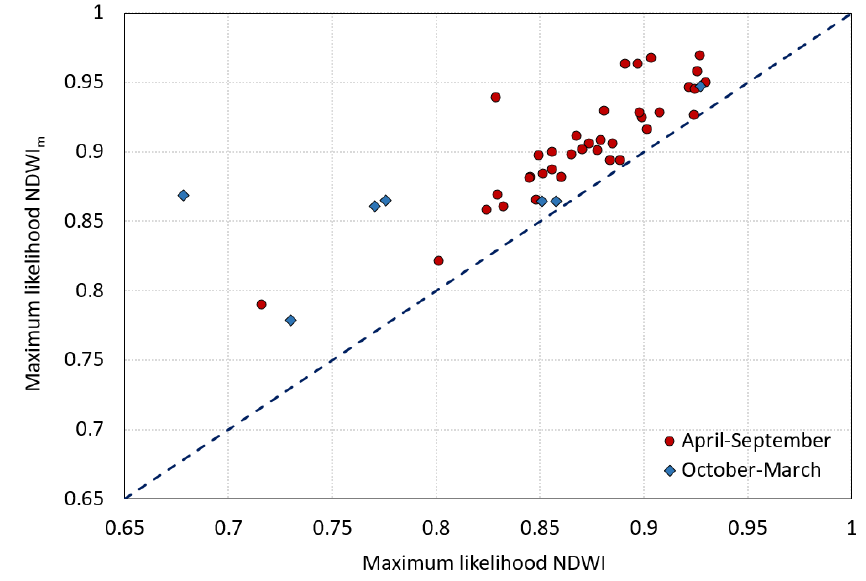
Figure 13. Maximum likelihood of the NDWI vs . the maximum likelihood of the NDWI m.